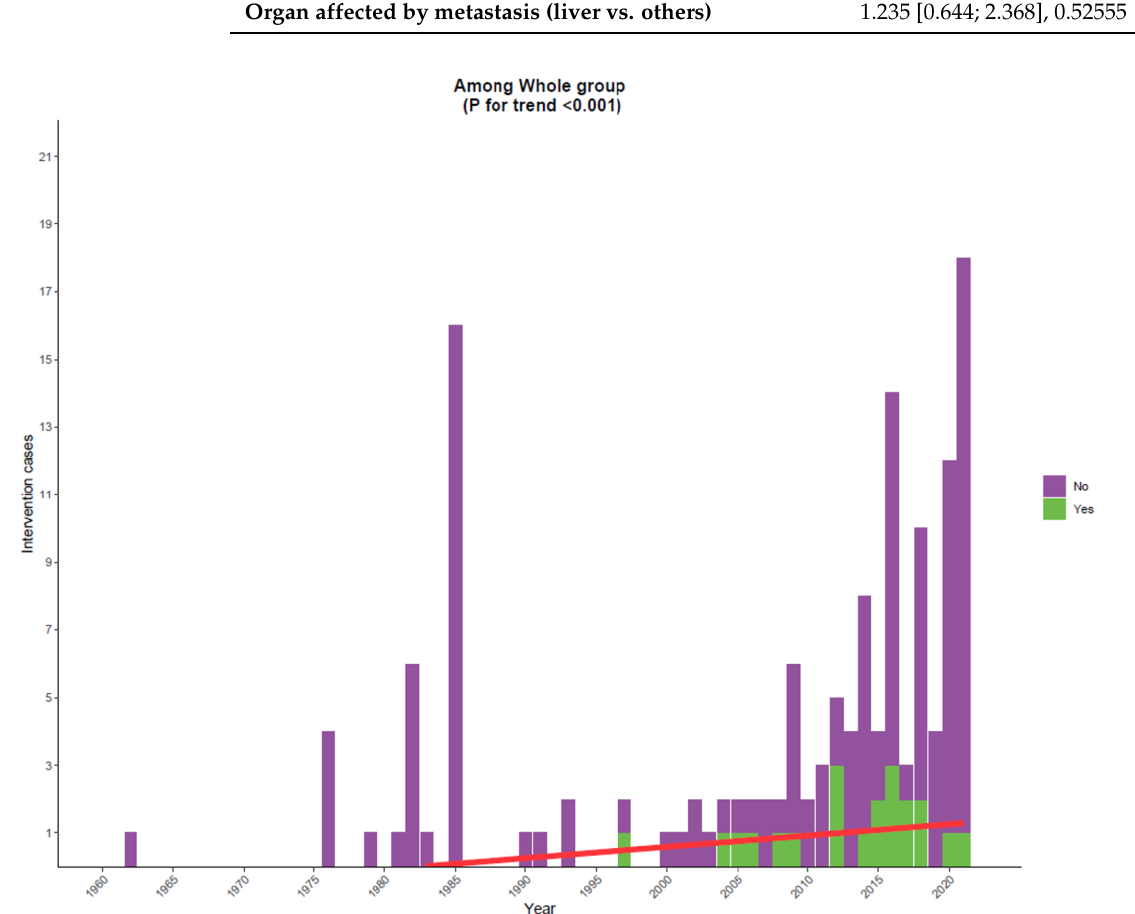
Figure 2. Stacked bar plot showing the number of cases that underwent intervention; while the rate of intervention is still low (21/144), there has been a progressive increase over the years.